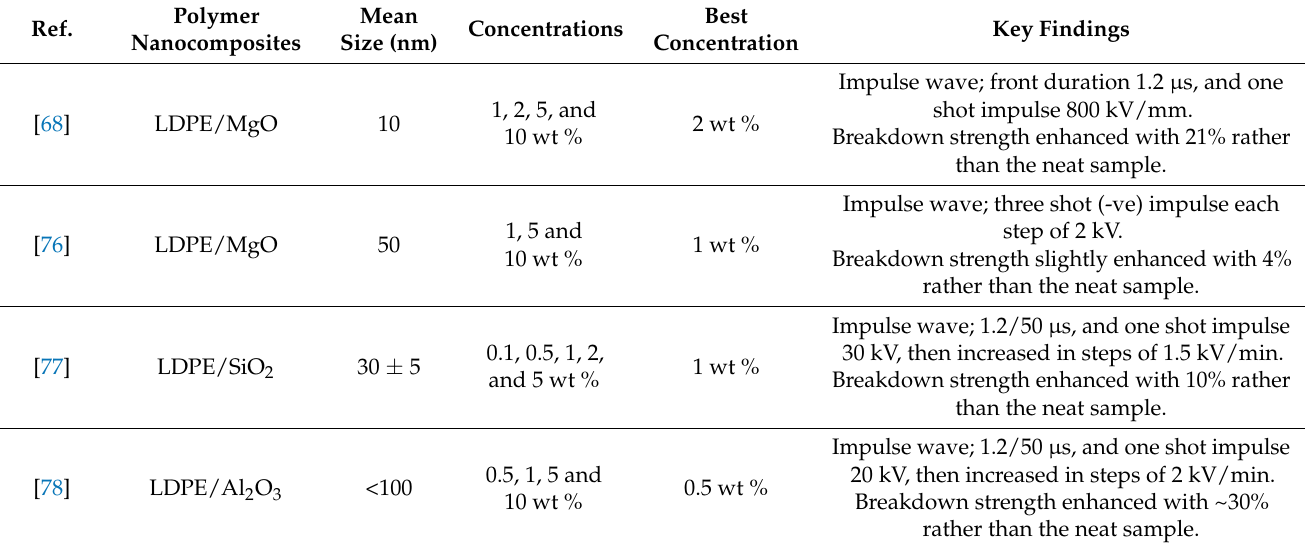
Table 3. Impulse breakdown strength of polymer nanocomposites based on PE and PVC.